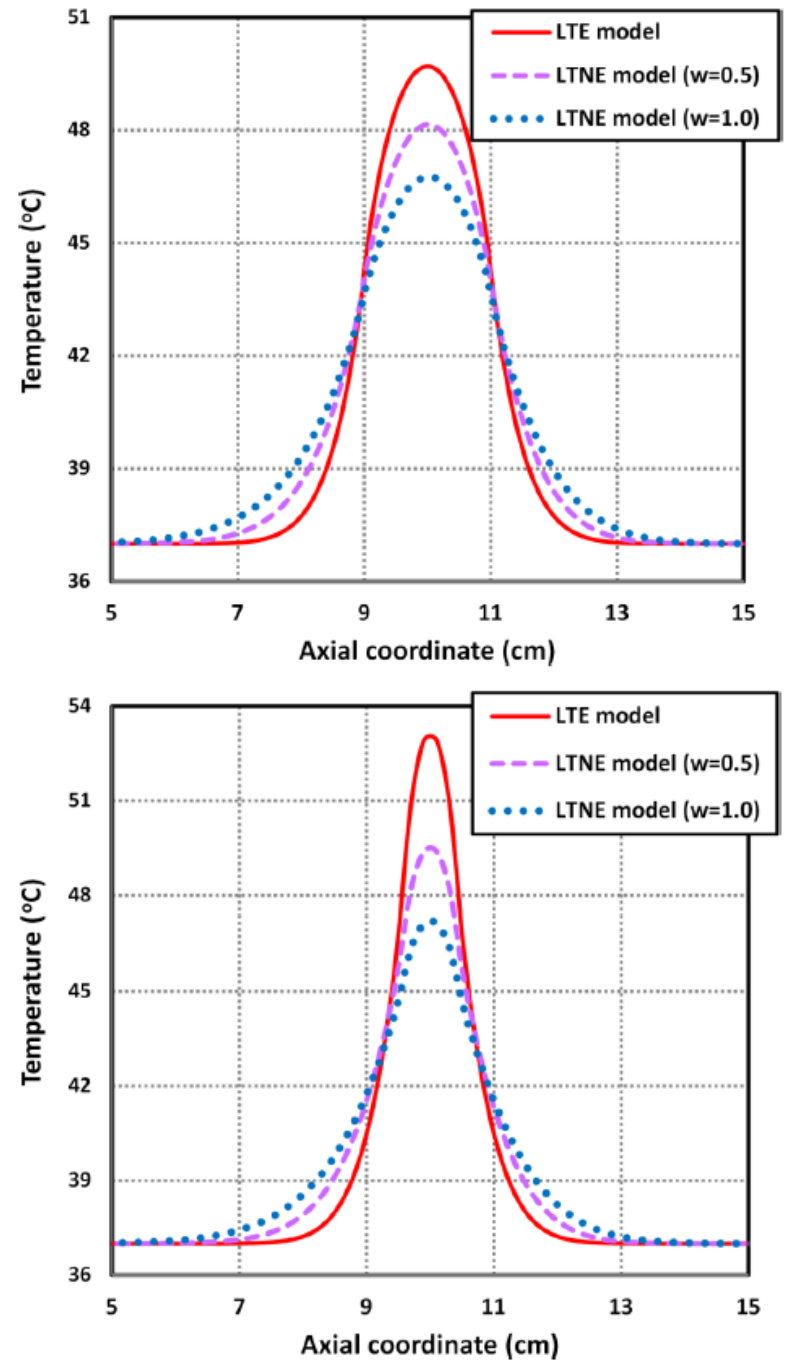
Figure 30. Profiles of temperature in the axial direction across the cylinder centre of blood, for two internal heat sources ( Top ) 200 kW/m 3 , and ( Bottom ) 400 kW/m 3 , and for two various perfusion rates ( w = 0.5 and 1.0 × 10 − 4 m 3 /s, investigated by Hassanpour and Saboonchi